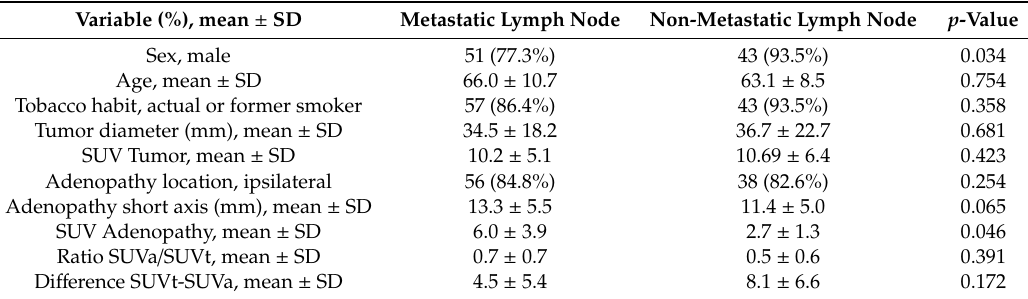
Table 2. Comparison of patients and lymph nodes characteristics according to EBUS-TBNA and final